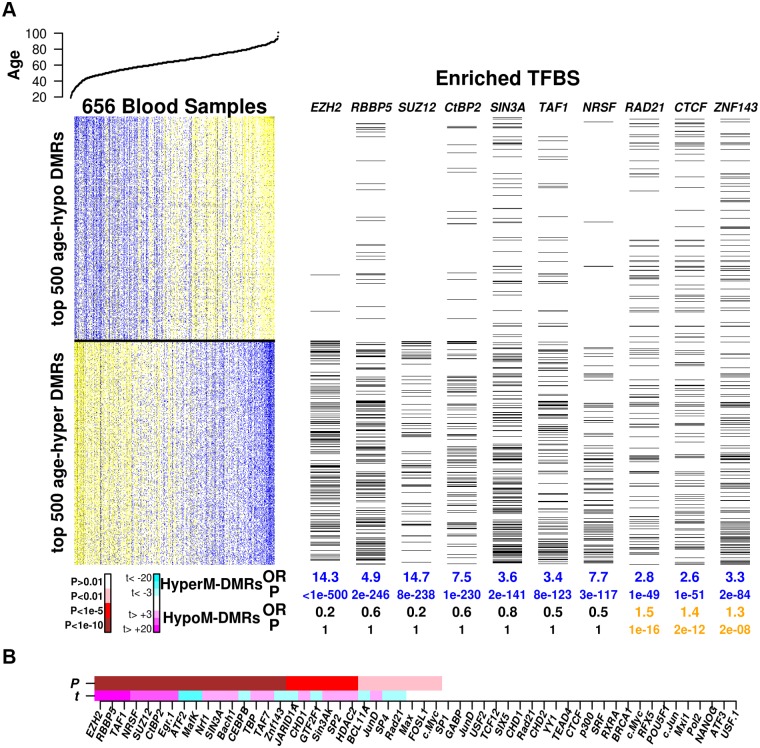
Enrichment of TFBSs among age-DMRs.
A) Left top panel depicts the age of the individuals from which the blood samples were taken, sorted by increasing age. Heatmap depicts relative DNA methylation levels for the top 500 age-hypomethylated and top 500 age-hypermethylated DMRs (blue = relative high DNA methylation, yellow = relative low DNA methylation), with samples sorted by increasing age. Right panel depicts (with black lines) which DMRs overlap with transcription factor binding sites (TFBS) for a number of TFs which exhibited highly significant enrichment either for age-hypermethylated or age-hypomethylated DMRs (or both). Below the panels we give the odds ratios (OR) and Fisher-test P-values (P) of enrichment of the corresponding TFBSs among age-hypermethylated and age-hypomethylated regions of the top 5% of age-DMRs. B) Combinatorial enrichment analysis of TFBSs. TFs have been sorted according to the strength of association (P-value) of their binding profile with the association of a region’s DNA methylation with age, as assessed from a multivariate linear regression model. Color code for P-values: white (P > 0.01), pink (P < 0.01), red (P < 1e − 5), brown (P < 1e − 10). Below P-value bar we show the corresponding estimated t-statistic in the multivariate analysis (magenta = strongly significant (P < 0.001) positive values, cyan = strongly significant (P < 0.001) negative values).